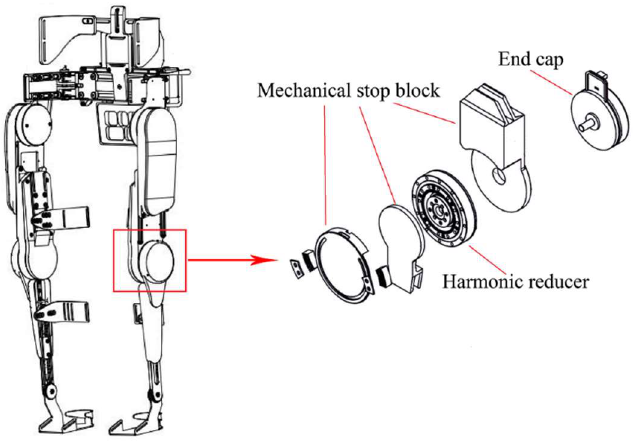
Figure 9. Model sketch of LEEX robot and harmonic reducer.